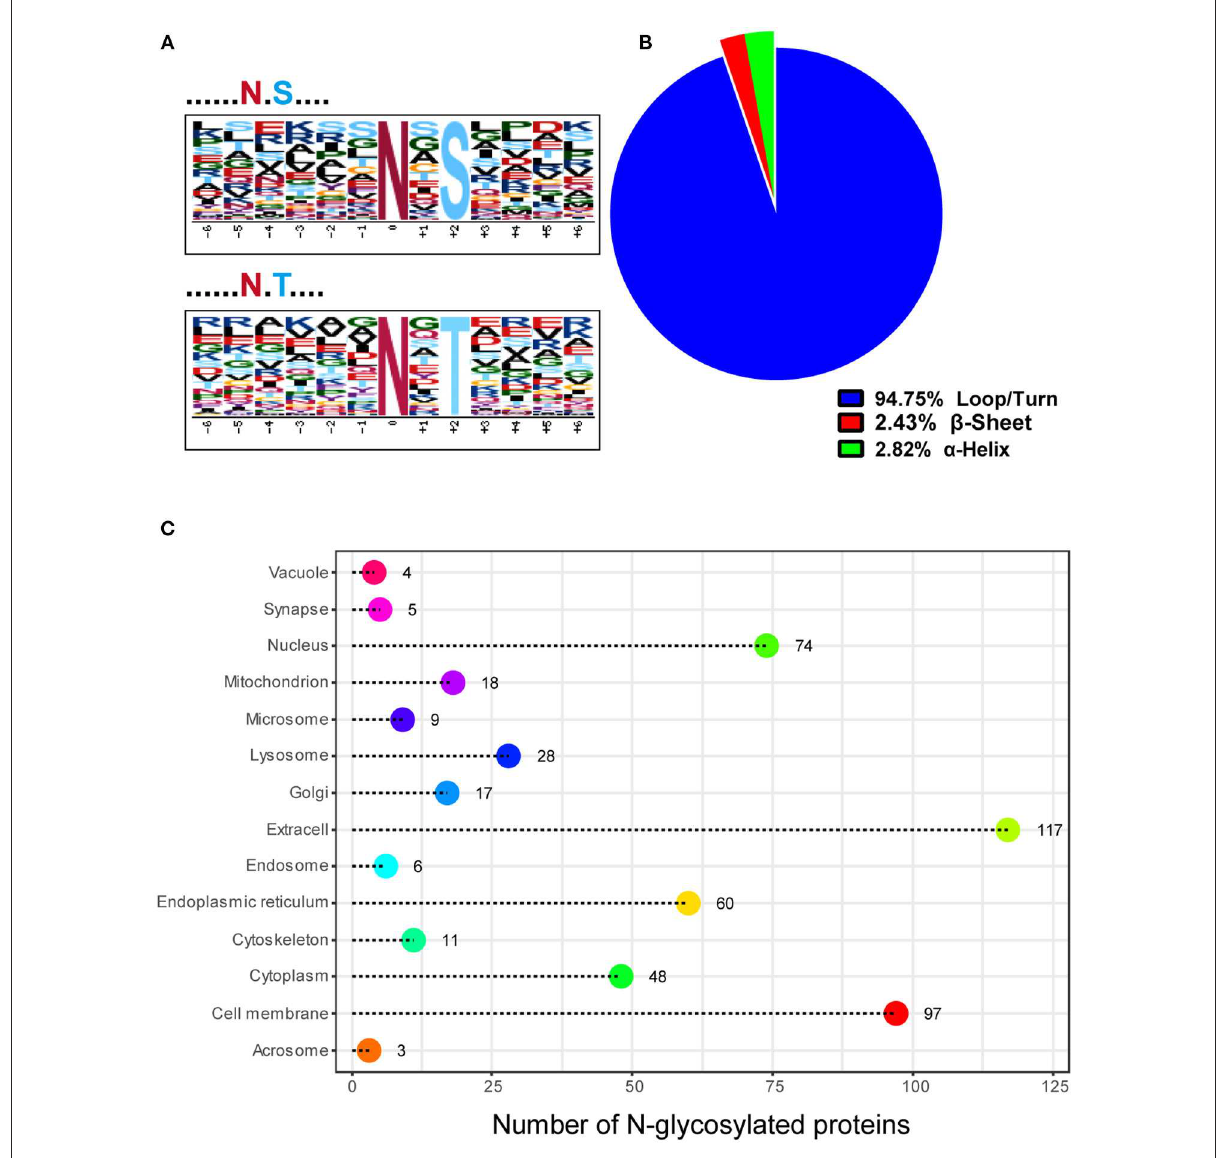
FIGURE3 Characteristics of the N-glycosylation sites and subcellular localization of N-glycoproteins in mink testis during spermatogenesis. (A) Two distinct motifs rich in N-glycosylated peptides, N-X-T (top) and N-X-S (bottom), were identified by Motif-X software. (B) The proportion of N-glycosylation sites with loops/turns, beta-sheets, and alpha-helix secondary structures. The secondary structure of most sites was loops/turns. (C) Subcellular localization of the N-glycoproteins identified in mink